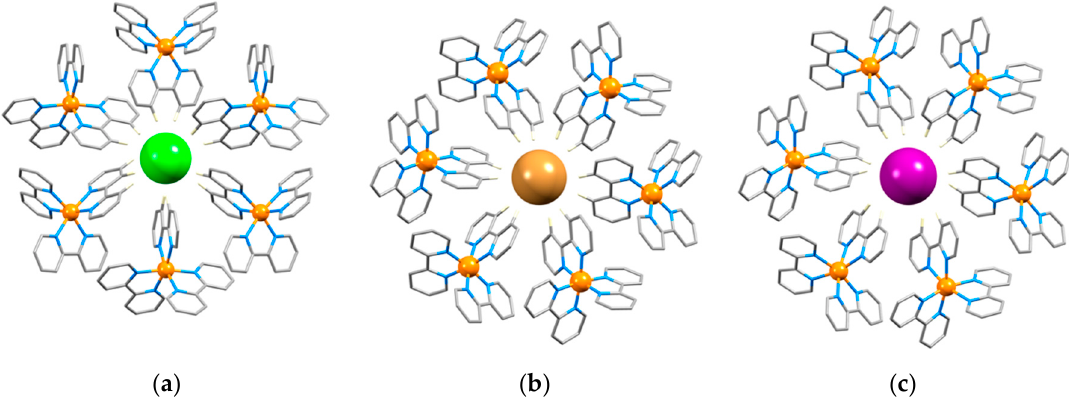
Figure 2. Structure Type 1 with ( a ) chloride ([Ni(bpy) 3 ]Cl 2 ·5.5H 2 O, Refcode EGOVEB) [90], ( b ) bromide ([Fe(bpy) 3 ]Br 2 ·5.5H 2 O, Refcode IFAFUR) [91] and ( c ) iodide ([Li(bpy) 3 ]I·bpy, Refcode REXVOF) [92] ions hosted. Halogen is shown in the space-filling mode, metal atoms in the ball and stick representation and orange, and all the other elements CPK colours. Hydrogen atoms, other than those involved in the interactions with the halide, are omitted.